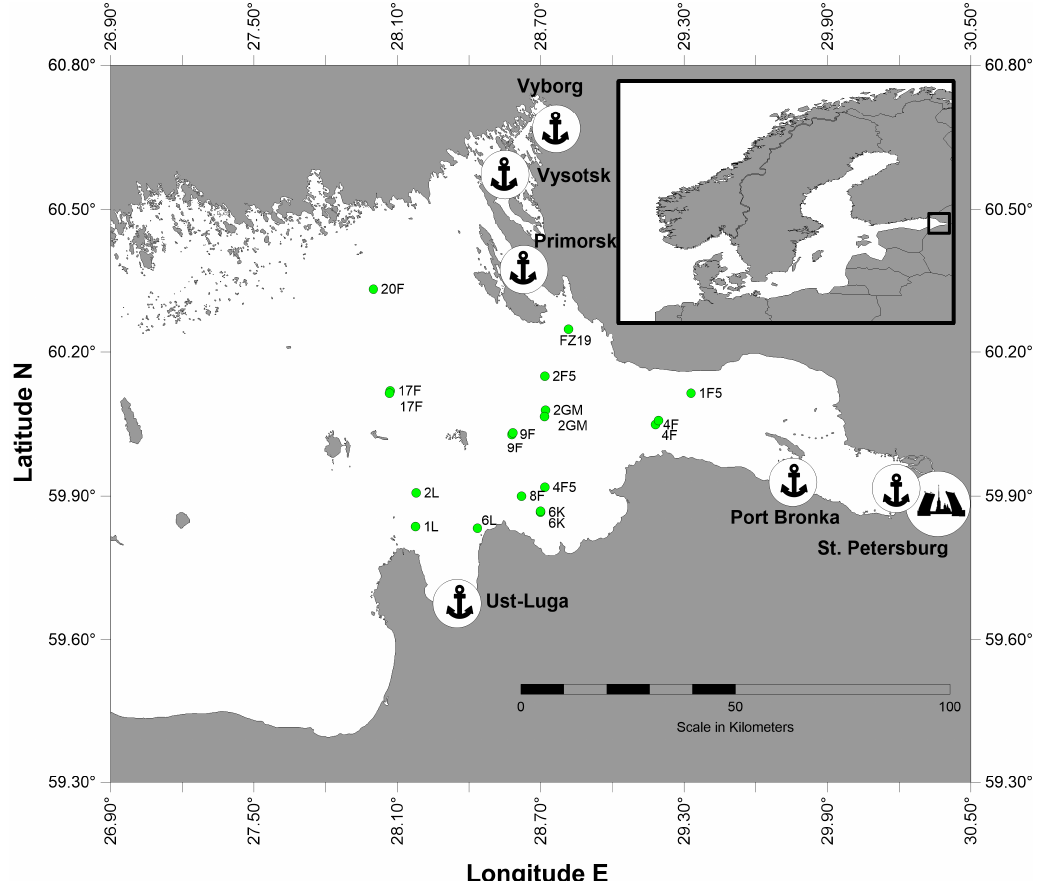
Figure 1. Sampling sites in the eastern Gulf of Finland.